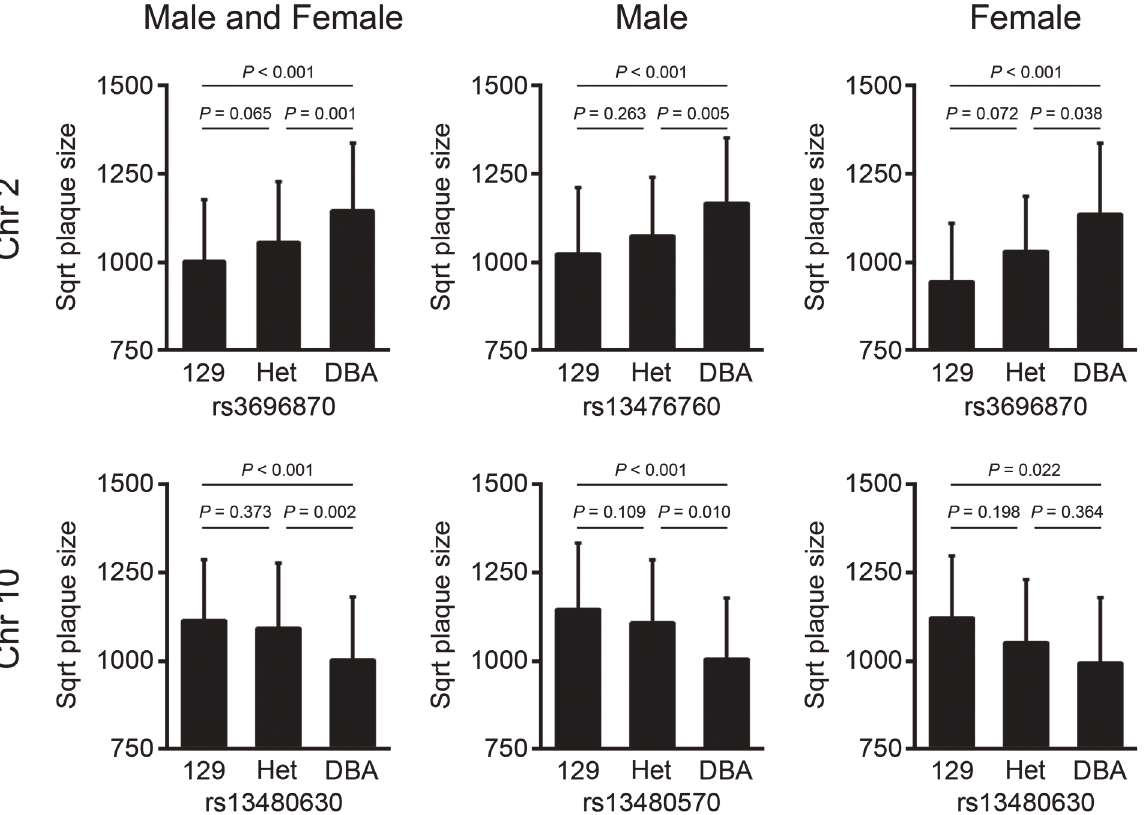
Aath5 most likely lies within the regions where the DNA sequence of 129 mice differs from